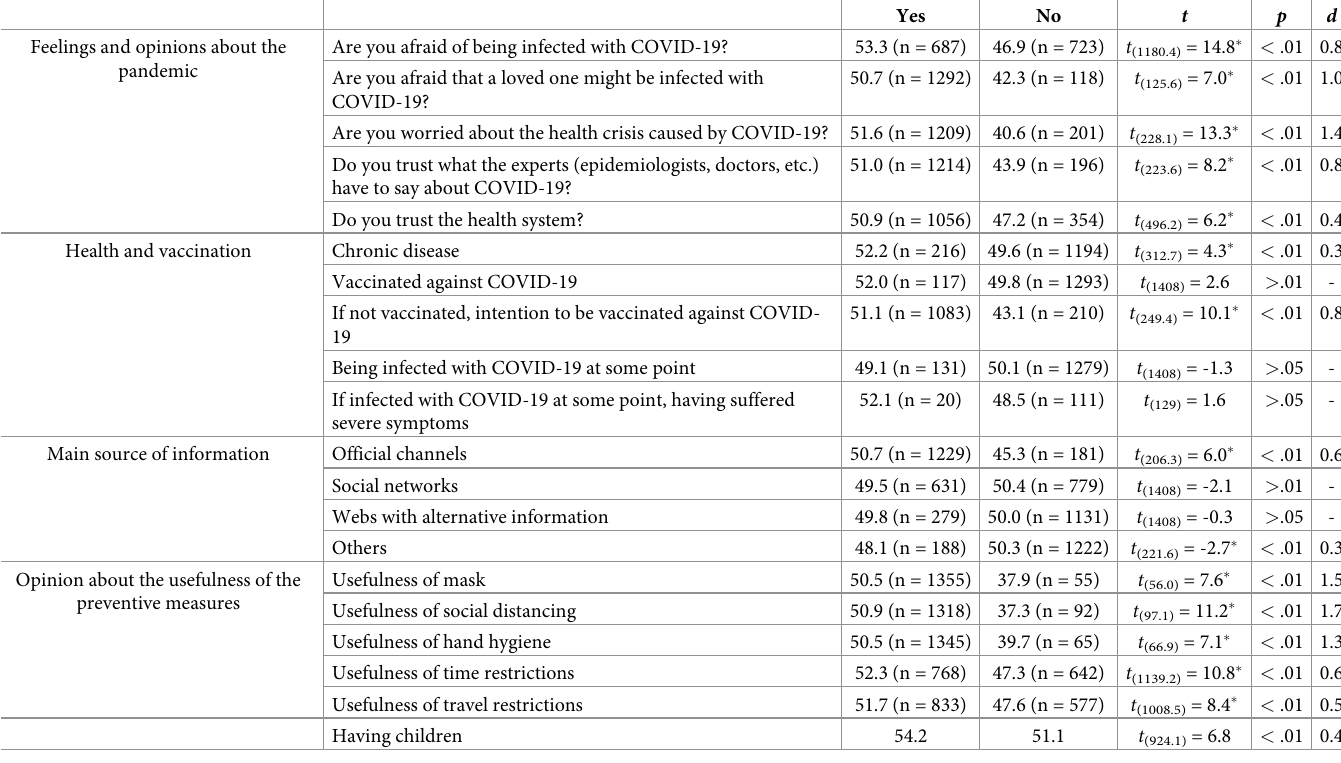
Table 4. Student’s t-test to assess the effect of several variables on the level of compliance with the preventive measures.